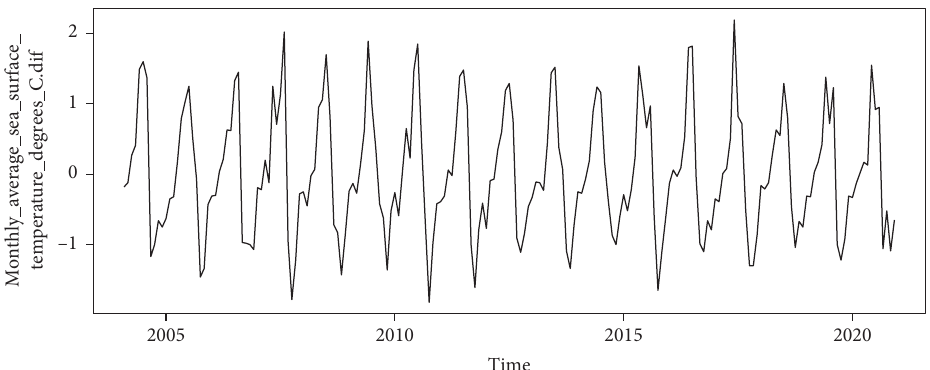
Figure 6: The time series diagram of the seawater temperature data of region 13 after first-order difference.